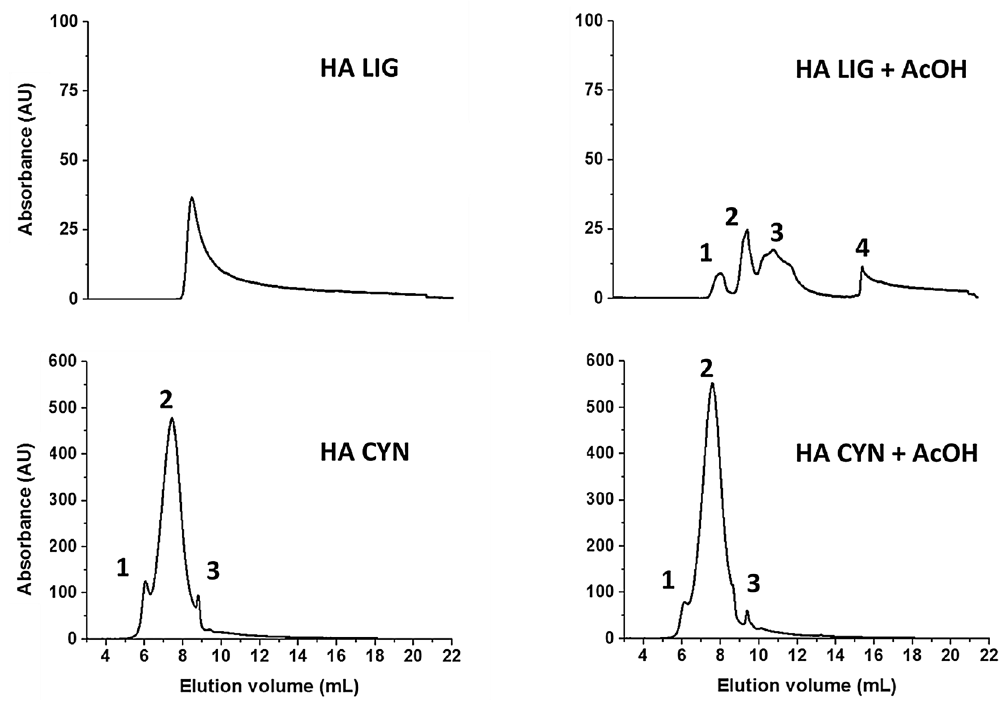
Figure 4. HPSEC chromatograms of HA-LIG and HA-CYN before and after addition of acetic acid (AcOH) to adjust sample pH from 7 to 3.5.